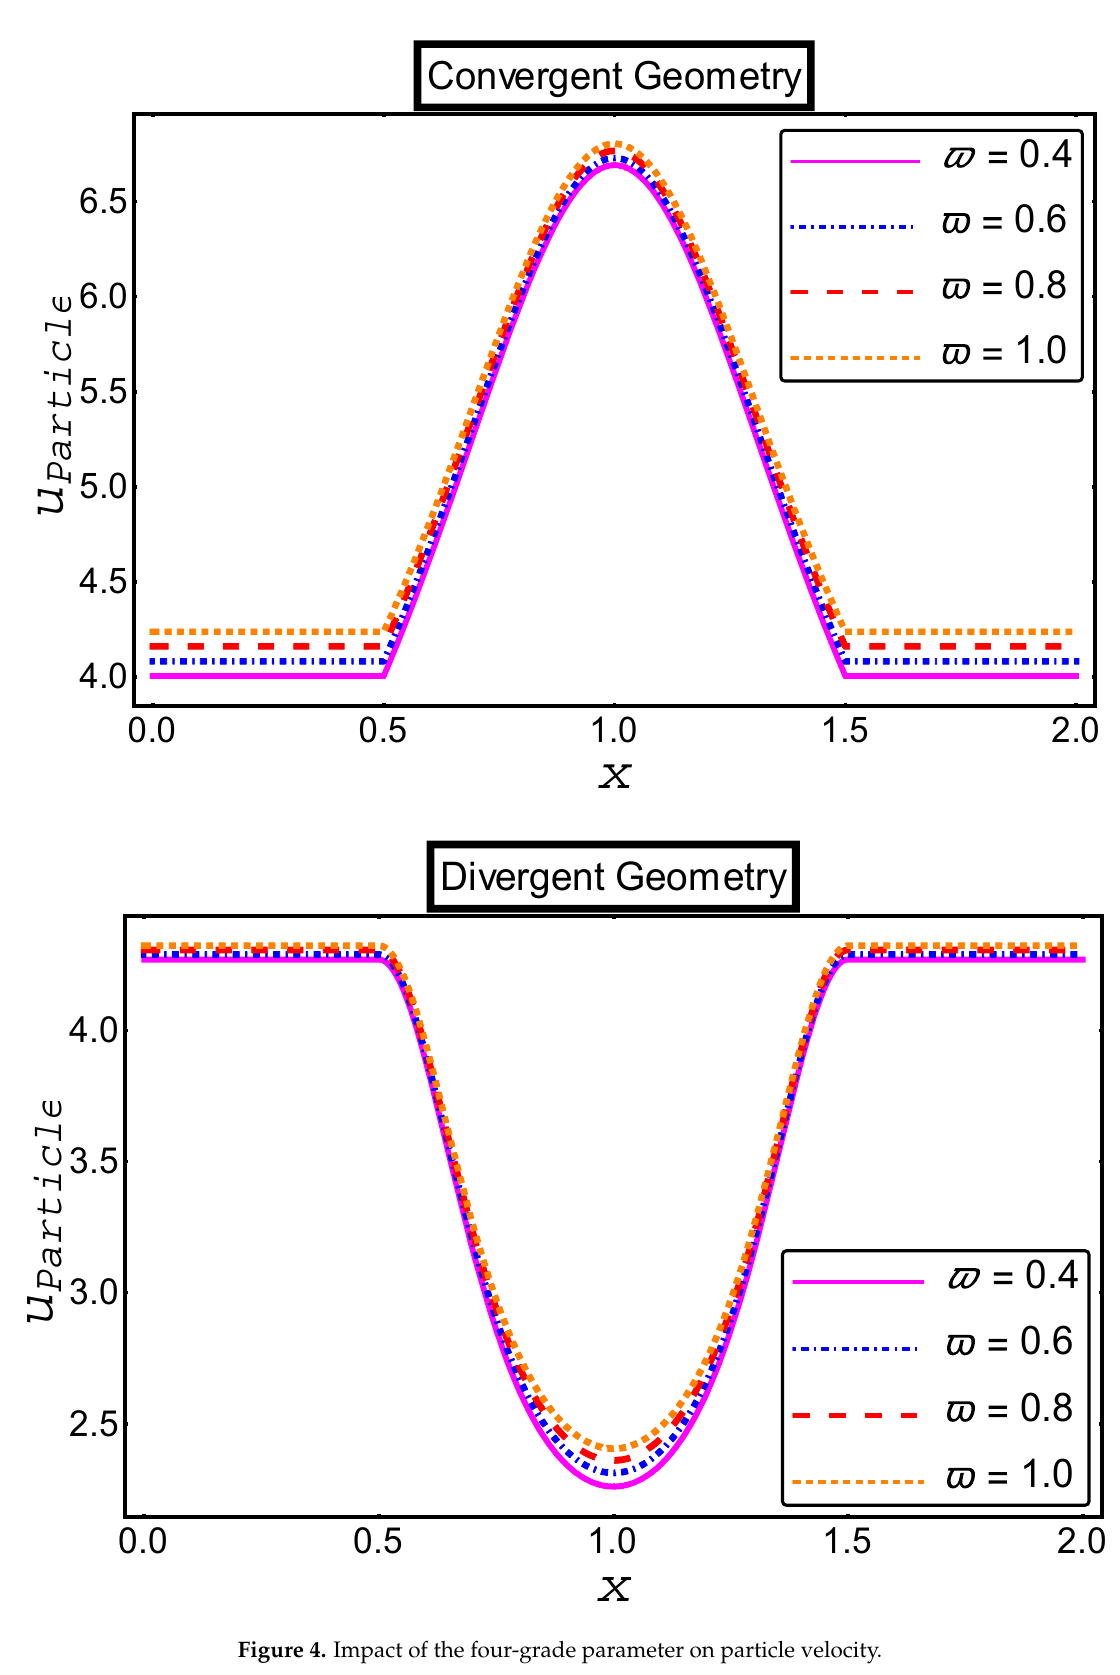
Figure 4. Impact of the four-grade parameter on particle velocity.